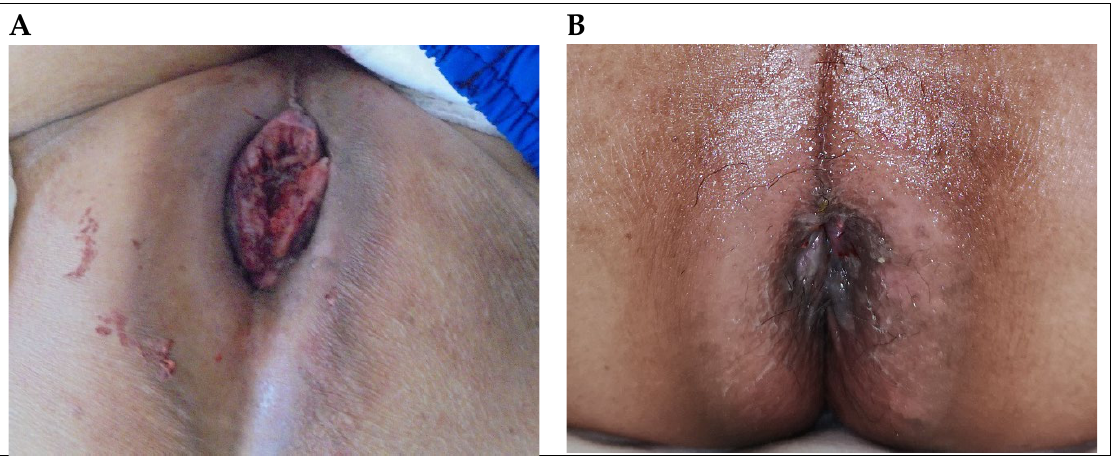
Figure 1. ( A ) Gross appearance of anal SCC protruding from the anus. ( B ) The tumor was almost not visible externally 2 months after combination therapy.